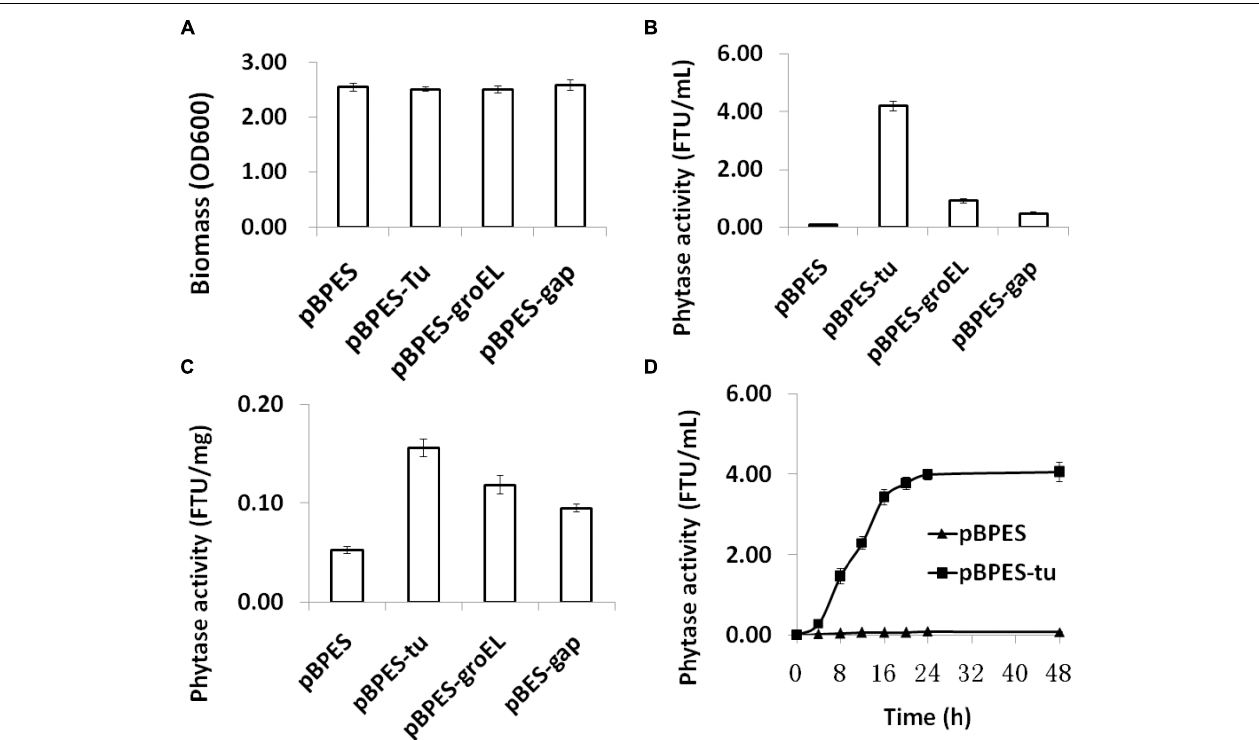
FIGURE 2 | Biomass and phytase expression of recombinant B. longum JCM 1217 grown in modified reinforced clostridia medium. (A) biomass of different strains assayed by reading optical density at 600 nm after anaerobic incubation for 48 h; (B) phytase activity in the CFMs after 48 h incubation of different strains; (C) phytase activity in the cell lysate after 48 h incubation of different strains; (D) time course phytase activity in CFMs of recombinant B. longum JCM 1217 harboring plasmid pBPES or pBPES-tu. Samples were collected at different time points during fermentation in the modified RCM. CFM, cell free medium; RCM, reinforced clostridia